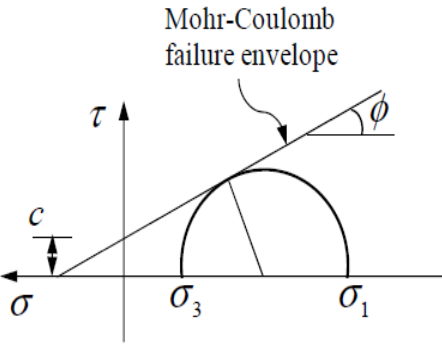
Figure 3. Mohr-Coulomb failure criterion.